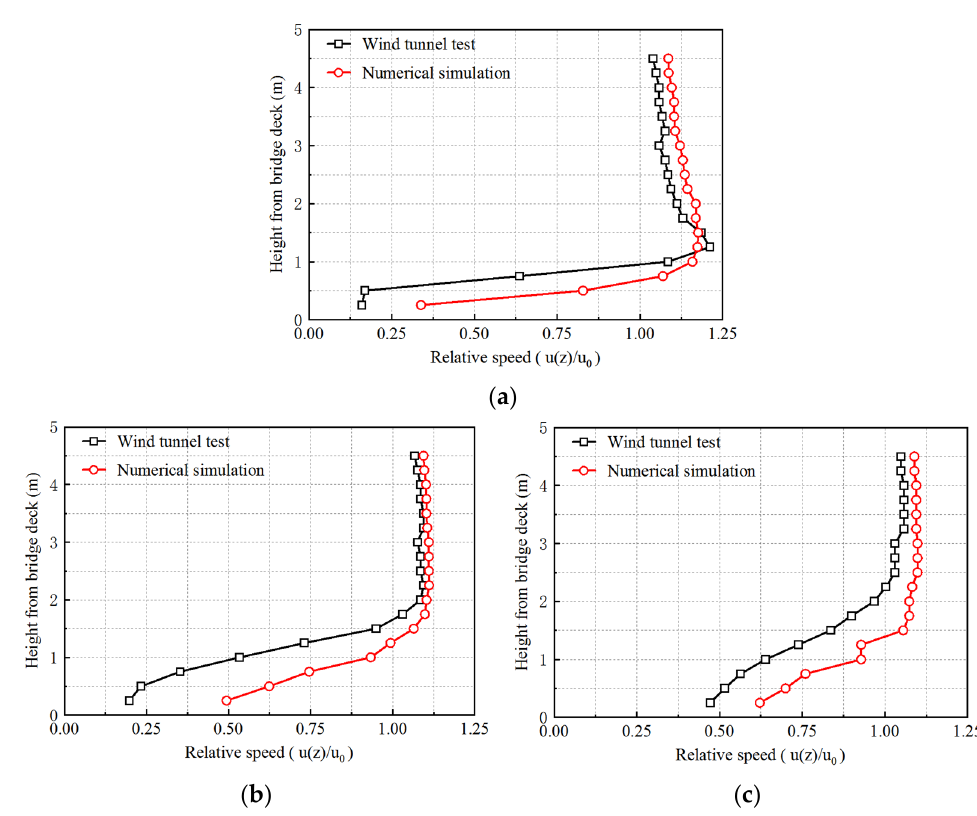
Figure 6. Comparison of relative wind speed values (u(z)/u 0 ) for bare bridge conditions ( a ) Lane 1; ( b ) Lane 2; ( c ) Lane 3.